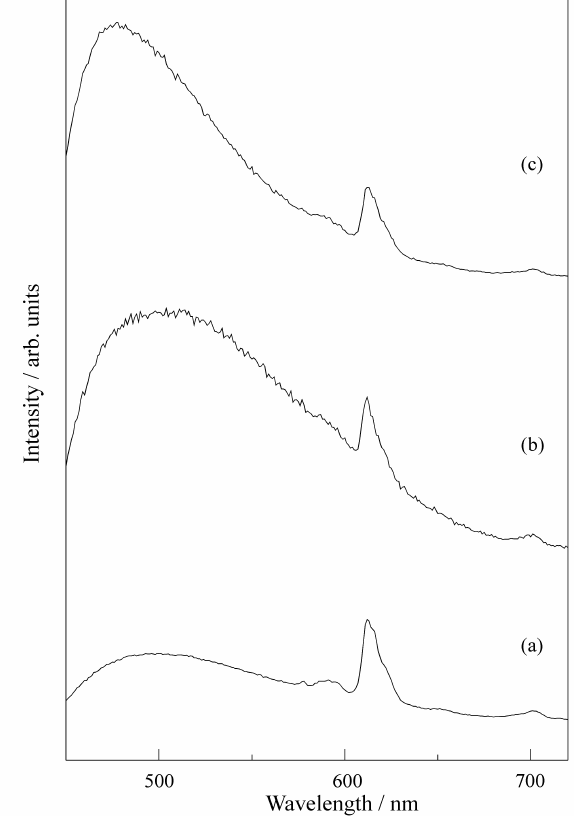
Figure 4. Eu 3+,2+ emission spectra in SiO 2 -TiO 2 (0.5% mol Eu 3+ ) xerogels obtained after 800 °C heat treatment under H 2 atmosphere (excitation at 340 nm). (a) 5 h; (b) 10 h and (c) 24